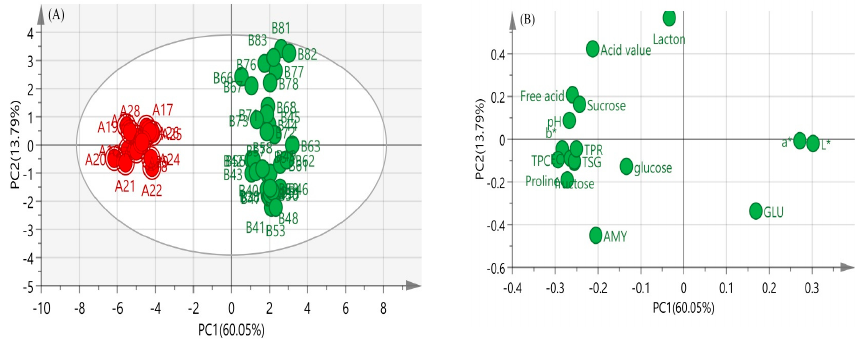
immature honey, which is in agreement with the result of the physicochemical parameters analysis.